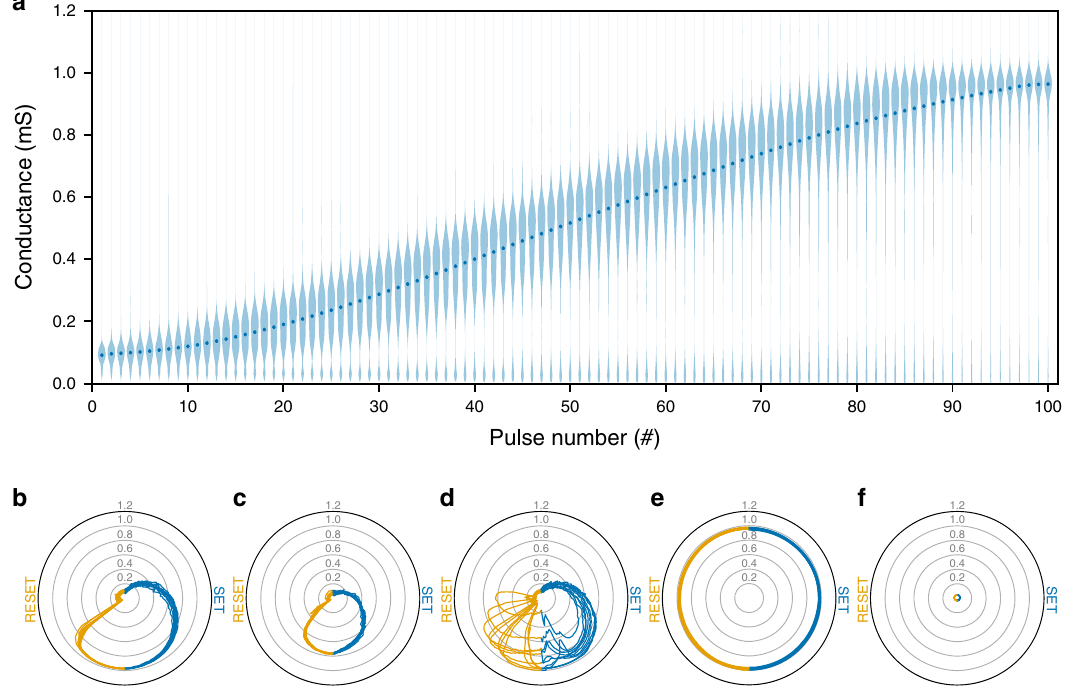
Fig. 2 Experimental data of Ta/HfO 2 RRAM crossbar array. Data of a crossbar of shape 128 × 64 were used. a Modulation of devices' conductance over 11 SET cycles, each consisting of a 100 potentiating pulses. Violin plots of gradual conductance changes are shown for all Ta/HfO 2 devices, with dots representing median conductance after a certain number of pulses. 100 points were used for Gaussian kernel density estimation. All violin plots have their maximum widths normalised. b – f Examples of devices with their conductance (in mS) b spanning the full range, c spanning part of the full range, d exhibiting cycle-to-cycle variability, e stuck at high values, and f stuck at low values. These diagrams show conductance of fi ve devices from Ta/HfO 2 crossbar array over 11 SET and RESET cycles. The radial component represents the conductance, while the angular component represents the number of applied pulses. The fi rst SET cycle starts at the top of each of the diagrams. The conductance (in blue) over 100 SET pulses is displayed in a clockwise fashion across the right half of each of the diagrams. Following that, conductance (in orange) over 100 RESET pulses (starting at the bottom) is displayed across the left half of each of the diagrams, after which the next cycle is displayed. Cartesian version of these plots is shown in Supplementary Fig.